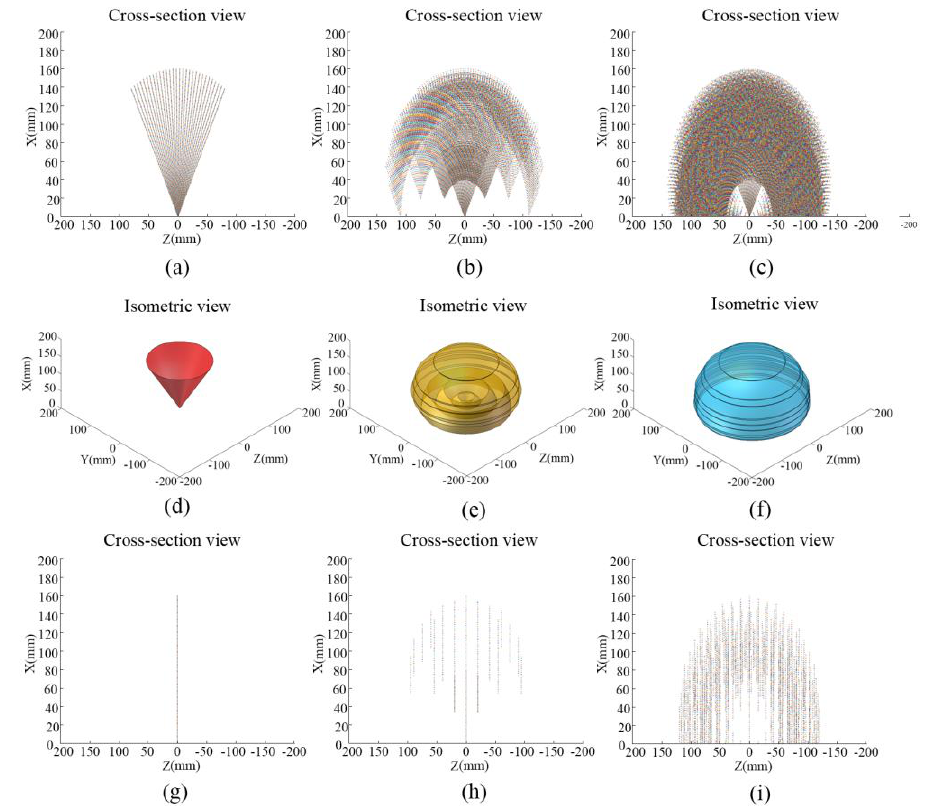
Figure 6. The workspace of articulated MIS tools with the straight conventional MIS tools ( a , d , g ), previously developed latching-type electromagnetic actuator ( b , e , h ) and hybrid actuator ( c , f , i ) in cross-sectional view, isometric view, and cross-sectional view with no tilt angle at the insertion point.